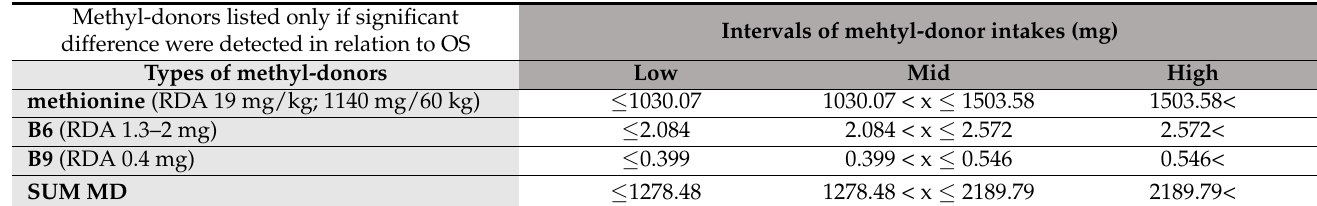
Table 2. Table for the groups of low, mid and high daily intakes of